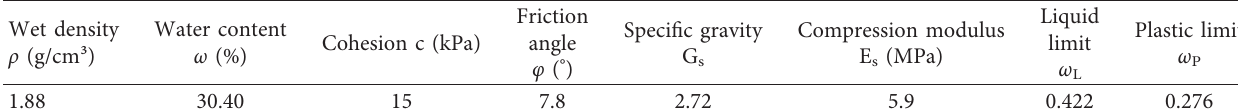
Figure 2: Ground subsidence (a) and damage (b) caused by deficiencies in concrete-encased underground electrical duct banks. Table 1: Physical and mechanical properties of soil.